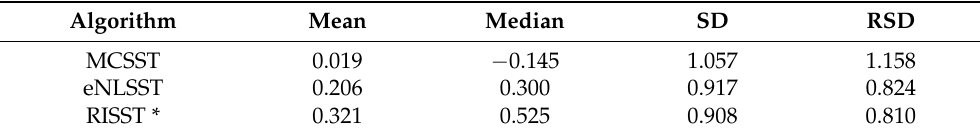
Table 2. Performance of the MCSST, eNLSST, and RISST algorithms (* denotes the proposed improve- ment algorithm).